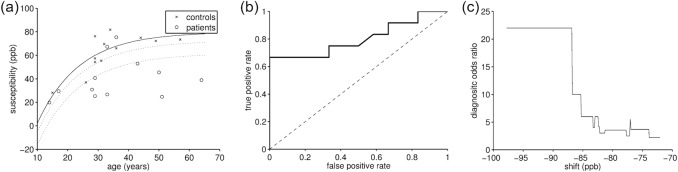
Detailed analysis of susceptibility in the red nucleus.(a) Susceptibility of patients and controls as a function of age. The solid line indicates the fitted normal aging trajectory. The dotted lines represent the area that provided optimal separation of patients and controls. (b) ROC curve of the classification into patients and controls by shifting the aging trajectory in (a, straight line) and considering individuals with lower susceptibility as patients. (c) Diagnostic odds ratio of the separation.